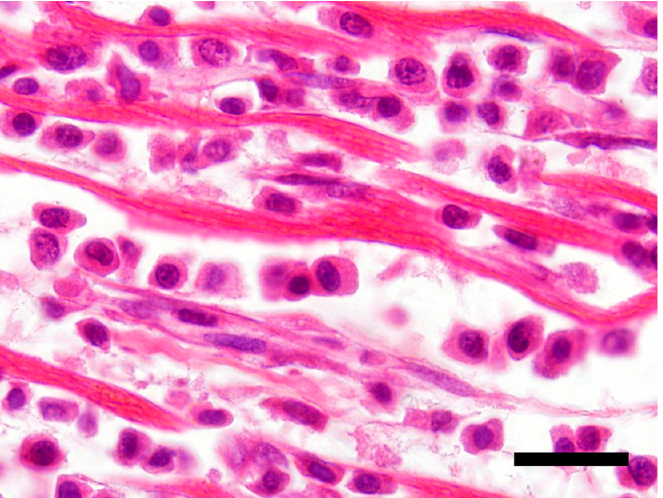
Figure 2. Neoplastic T-cells with a plasmacytoid appearance showing marked anisocytosis and anisokaryosis with moderate to large amounts of bright eosinophilic cytoplasm. H&E stain 100×, Bar = 20 µm.